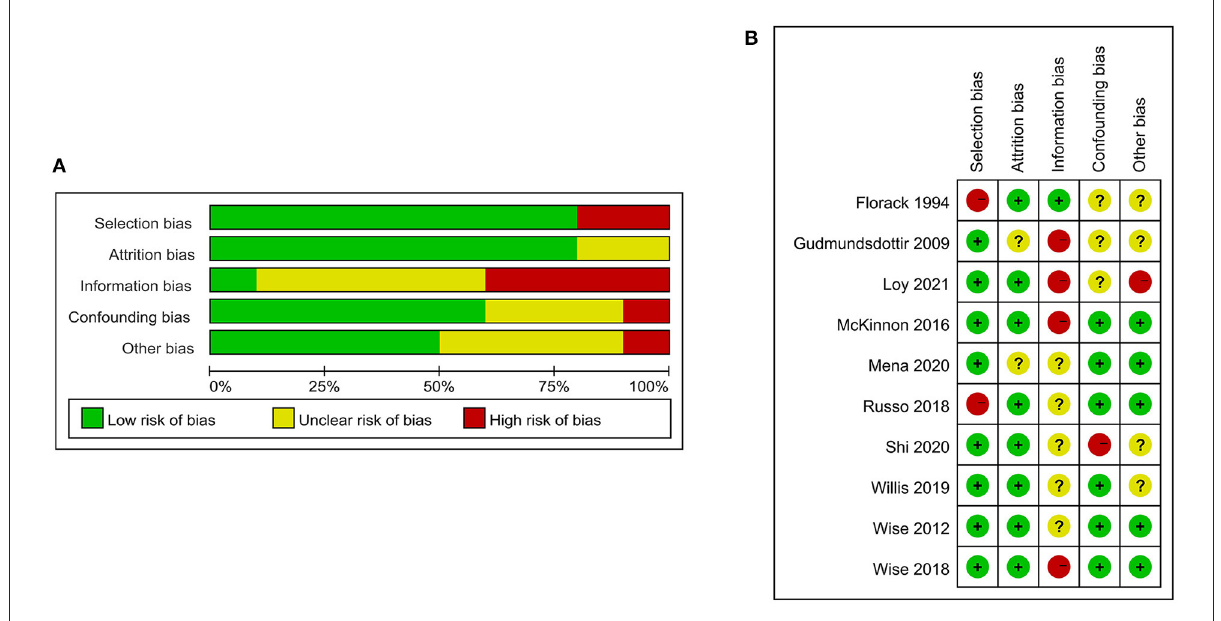
FIGURE2 Bias risk assessment of 10 studies included in the meta-analysis.